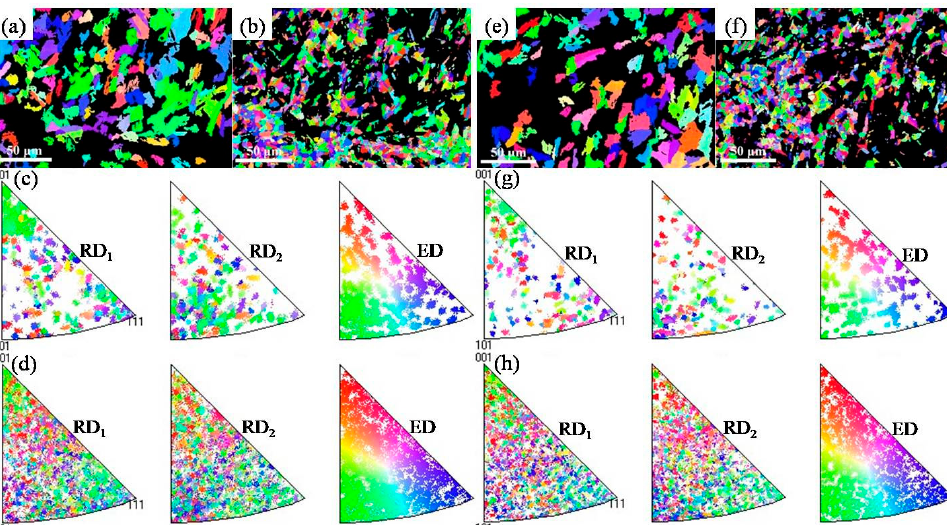
Figure 9. Orientation distribution of both un-recrystallized grains and recrystallized grains after different annealing times: ( a , e ) IPF image and ( c , g ) the corresponding IPF of un-recrystallized grains; ( b , f ) IPF image and ( d , h ) the corresponding IPF of recrystallized grains; ( a – d ) annealing for 15 min at 900 °C; and ( e – h ) annealing for 120 min at 900 °C.